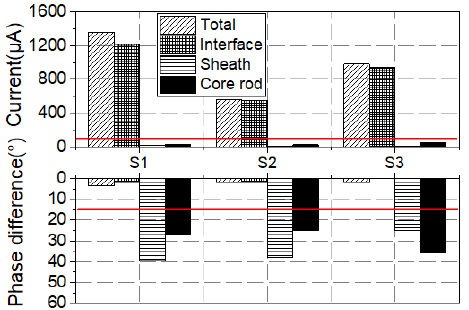
Figure 23. Measured results of voltage tests after water diffusion testing.